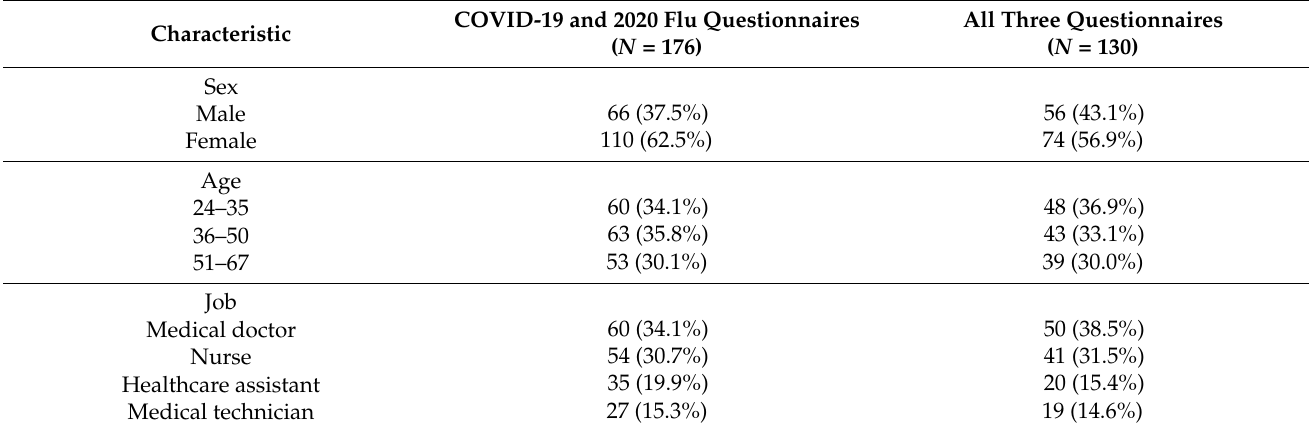
Table 1. Selected characteristics of the study population.